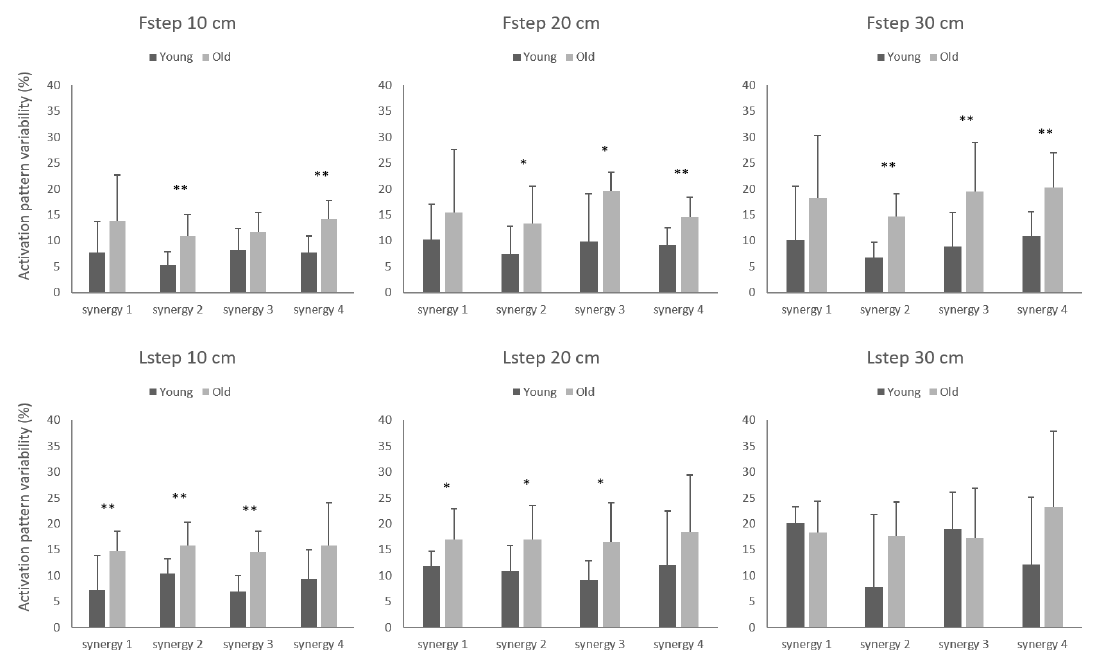
Figure 5. Between-subject variability (time-averaged standard deviation) of temporal activation patterns across time-normalized trials, expressed as a percent of 100 (in arbitrary units, n synergies = 4). Data are displayed separately for forward (Fstep) and lateral (Lstep) step directions with step heights of 10, 20 and 30 cm. * indicates a significant difference at p = 0.05, ** indicates a significant difference at p =